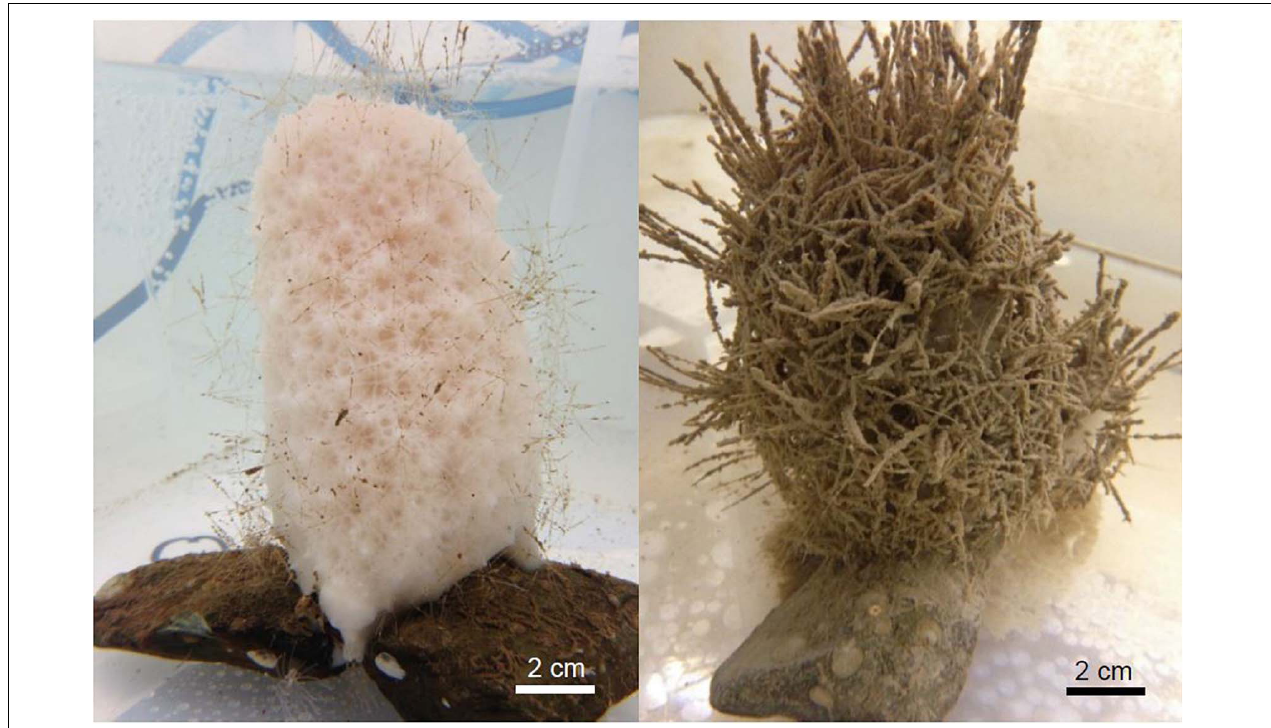
FIGURE 4 | Individuals of Vazella pourtalesii from the control (left) and the exposure (right) group after 7 days in the experiment. The long spicules and atrial surface of the exposed sponges eventually became densely covered with sediment particles.